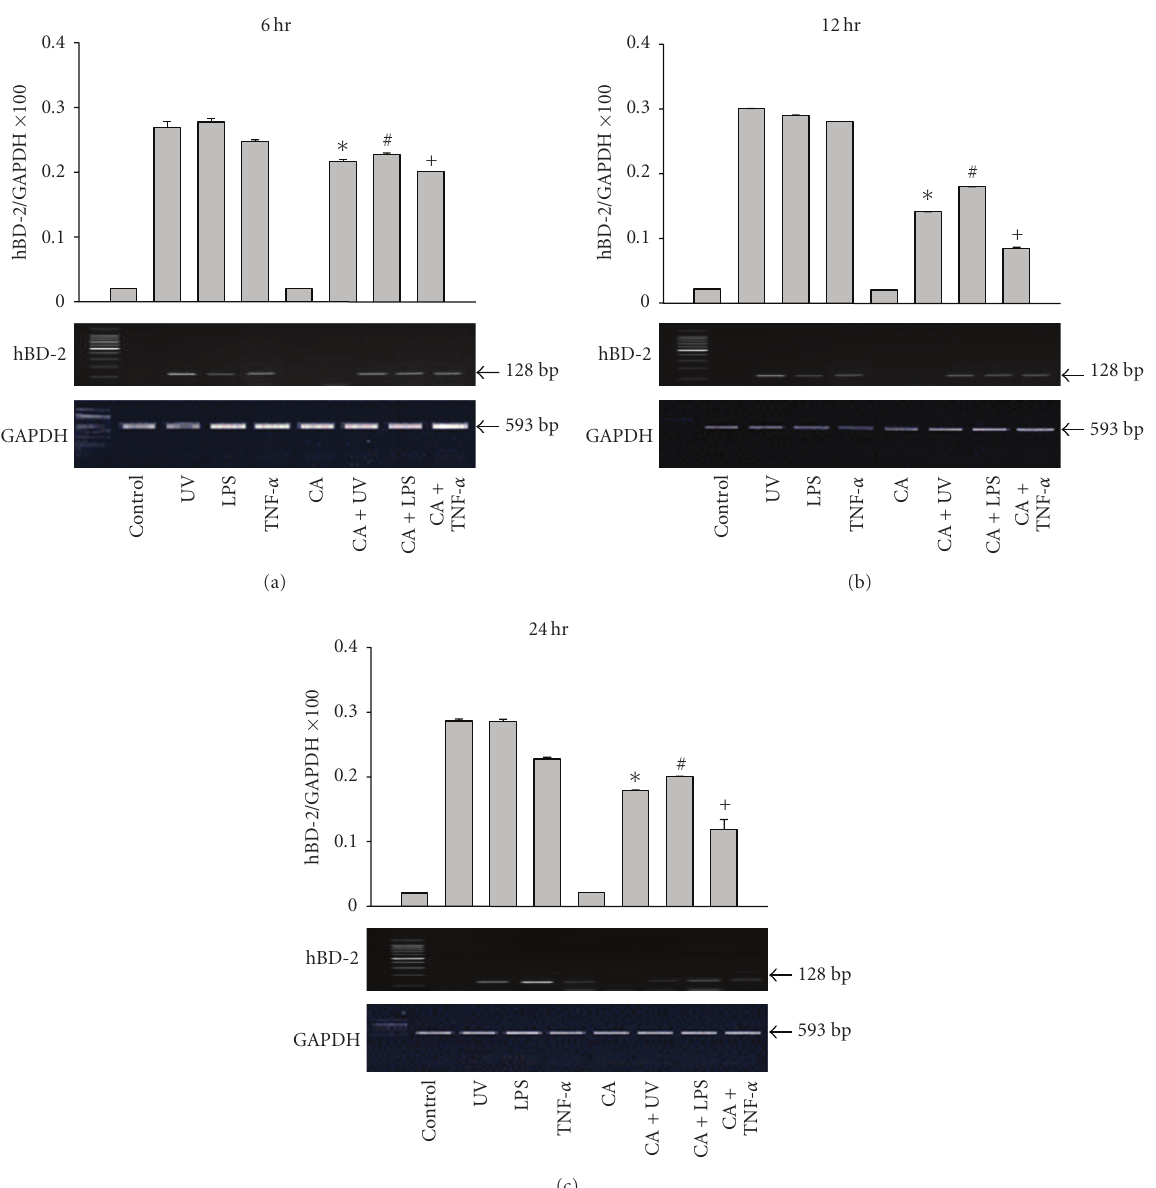
Figure 1: The expression of hBD-2 mRNA in keratinocytes was upregulated when stimulated with LPS, TNF- α , and UVB irradiation at 6, 12, and 24 hours. The hBD-2 mRNA expression was decreased after treatment with calcipotriol (CA). ∗ : Statistically significant between UV and CA + UV ( P < . 01). #: Statistically significant between LPS and CA + LPS ( P < . 01). +: Statistically significant between TNF-s and CA + TNF-a ( P < 0 .